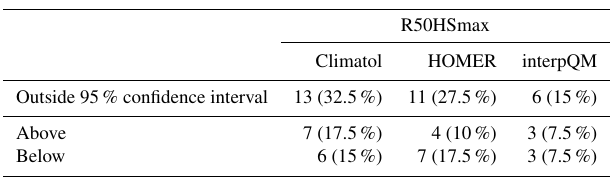
Table 4. Statistics for R50HSmax: number and percentage of sta- tions that are outside the original’s 95% confidence intervals for each homogenisation